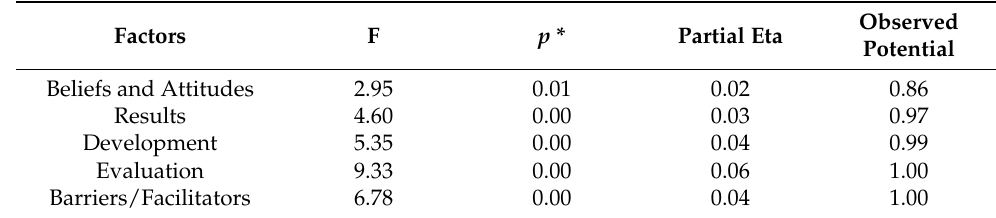
Observed Potential